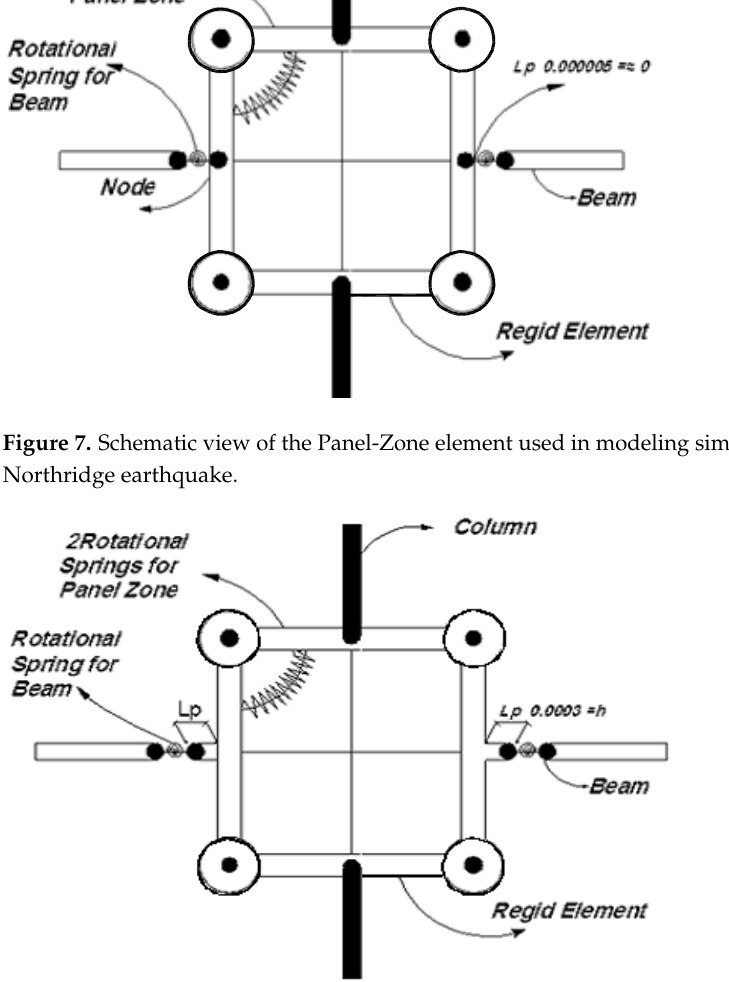
Figure 8. Schematic view of the Panel-Zone element used in modeling connections after the Northridge earthquake (corresponding to the RBS connection).